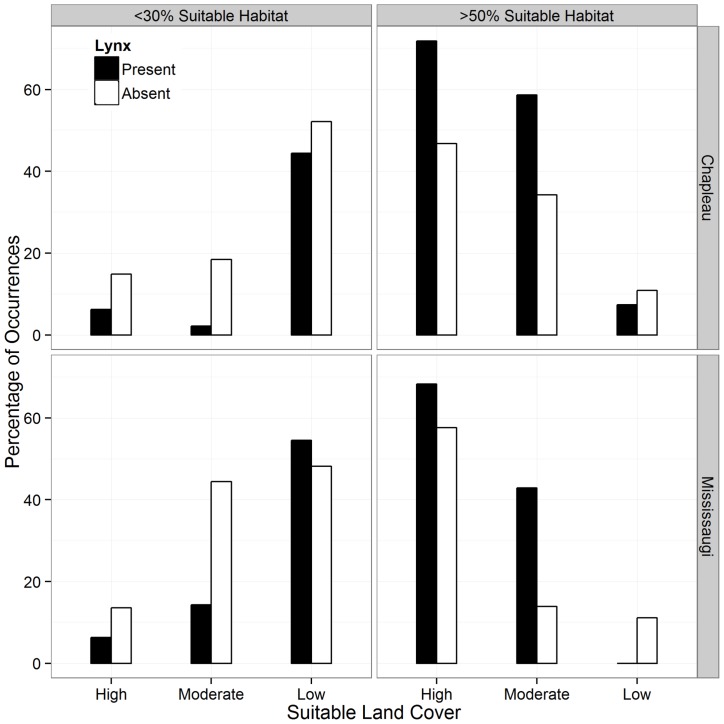
Distribution of lynx occurrences and pseudo-absences in relation to the amount of suitable habitat at the 25 km2 scale in the regions of Chapleau and Mississagi with three levels of suitable land cover.